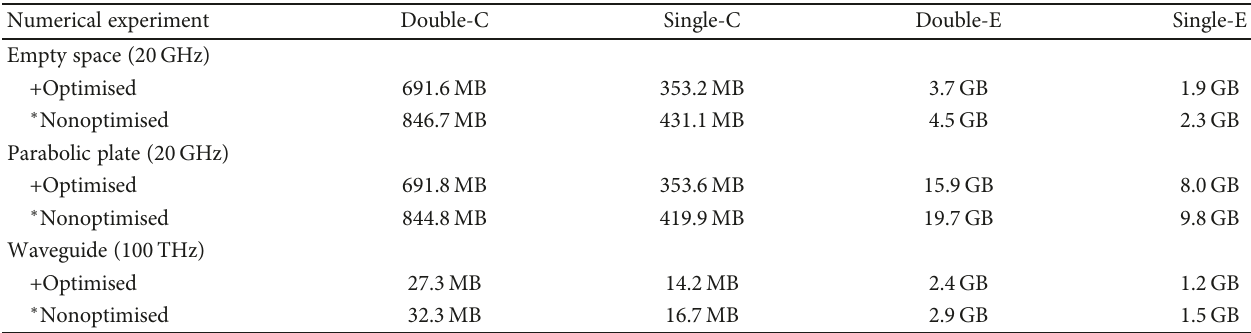
ffi ce. Figure 20: Behaviour of the electric fi eld E z in the viewers of the second o Table 6: Amount of allocated memory used by the optimised version in double and single precision, for the di ff erent numerical experiments. The used memory is reported by the operating system (Linux kernel